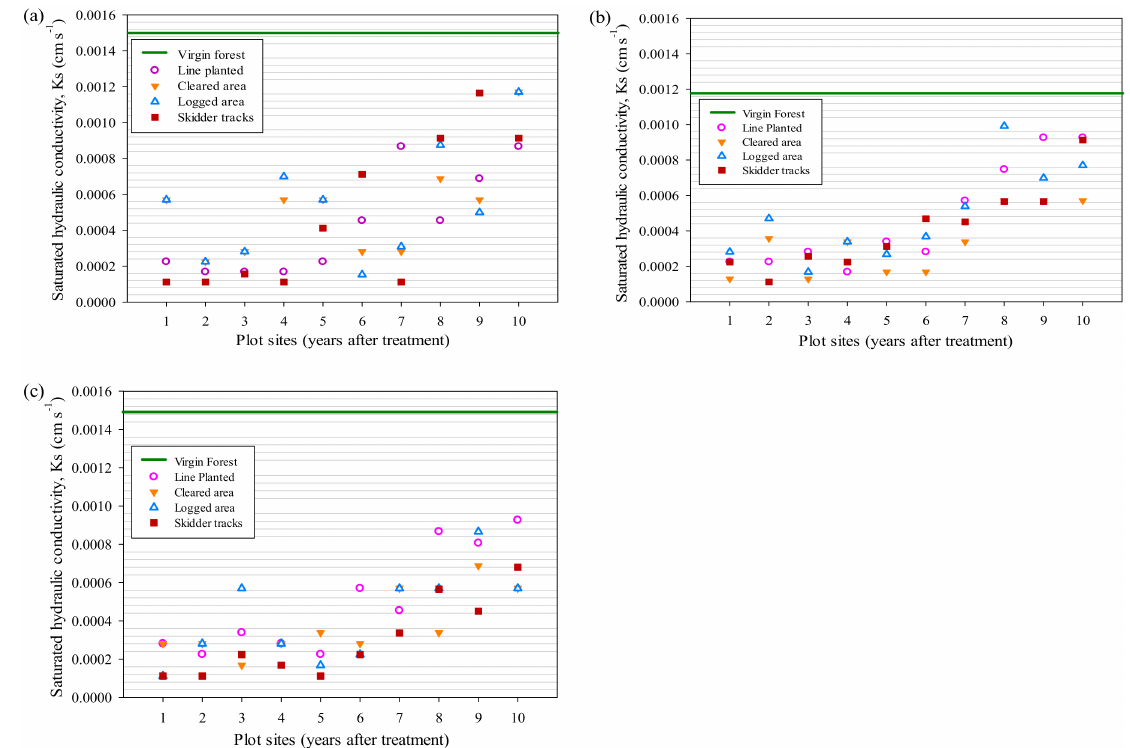
Figure 7. Saturated hydraulic conductivity ( K s ) at all 11 plots, calculated from infiltration measurements taken in each area. ( a ) Upper slope. ( b ) Middle Slope. ( c ) Lower